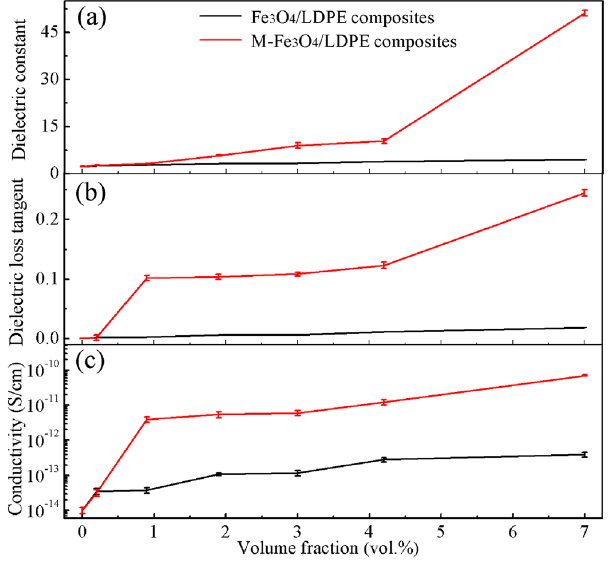
Figure 5. ( a ) Dielectric constant ( b ) dielectric loss tangent and ( c ) conductivity of the Fe 3 O 4 /LDPE and M-Fe 3 O 4 /LDPE composites at different volume fraction of Fe 3 O 4 filler at 10 Hz.